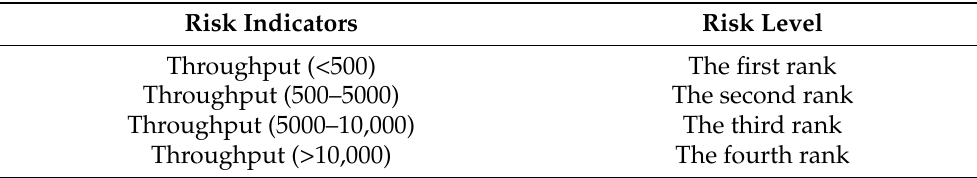
Table 3. Risk indicators of the